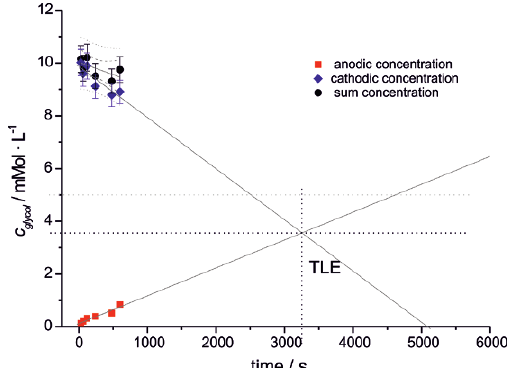
Figure 15. Exp. 4a: Transport of glycol from anode to cathode beaker. The grey dashed line marks the theoretical mixture concentration (5 mM); the black dashed lines show concentration and time at the theoretical linear equilibrium (TLE). The concentration sum is evaluated with a linear fit including 95% confidence (dashed) and 95% prediction (dotted) intervals.